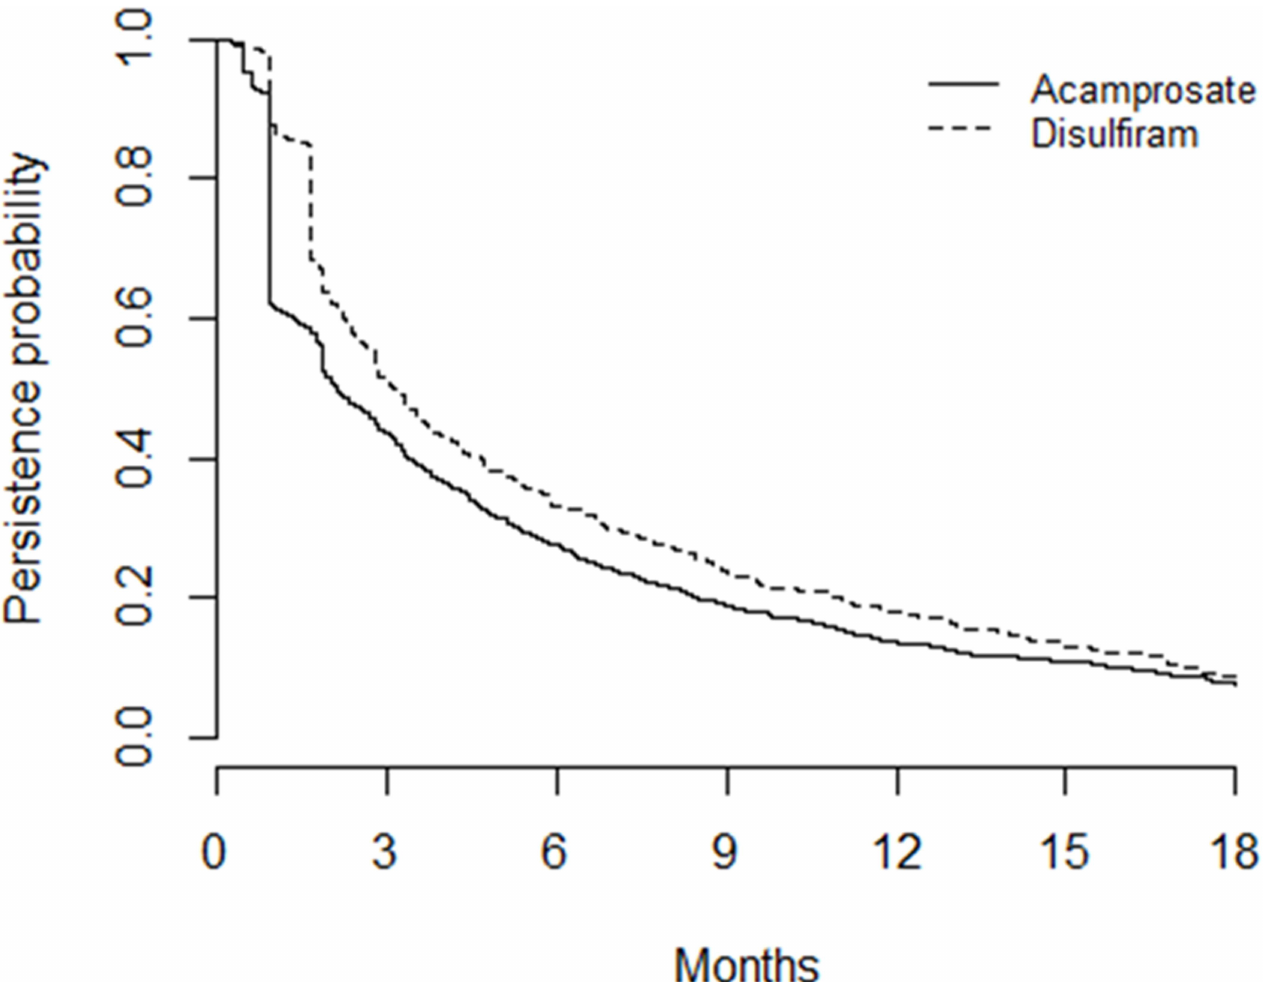
Fig 2. Persistence of prescribing for acamprosate and disulfiram for 18 months after the date of first prescription. Number at start of analysis: acamprosate= 1,257; disulfiram= 394.